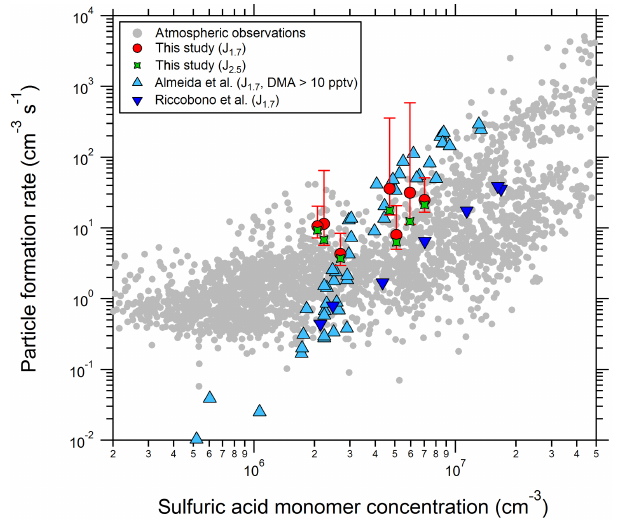
Figure 9. Particle formation rates from this study at a mobility di- ameter of 1.7nm ( J 1 . 7 , red circles) and 2.5nm ( J 2 . 5 , green stars). Data from CLOUD chamber measurements for a diameter of 1.7nm are shown in addition for the system of sulfuric acid, water and dimethylamine (light blue symbols; see Almeida et al., 2013) and sulfuric acid, water and oxidized organics from pinanediol (dark blue symbols; see Riccobono et al., 2014). The light-gray circles are from other field measurements (Kuang et al., 2008; Paasonen et al., 2010; Kulmala et al., 2013).